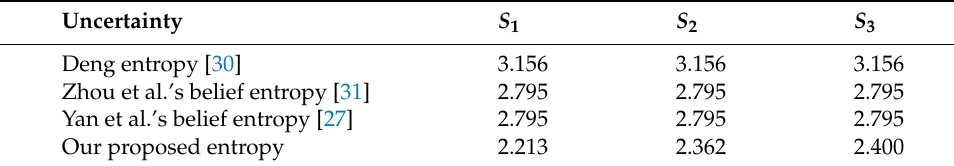
Table 2. Uncertainty measure of Example 1 with four entropies.